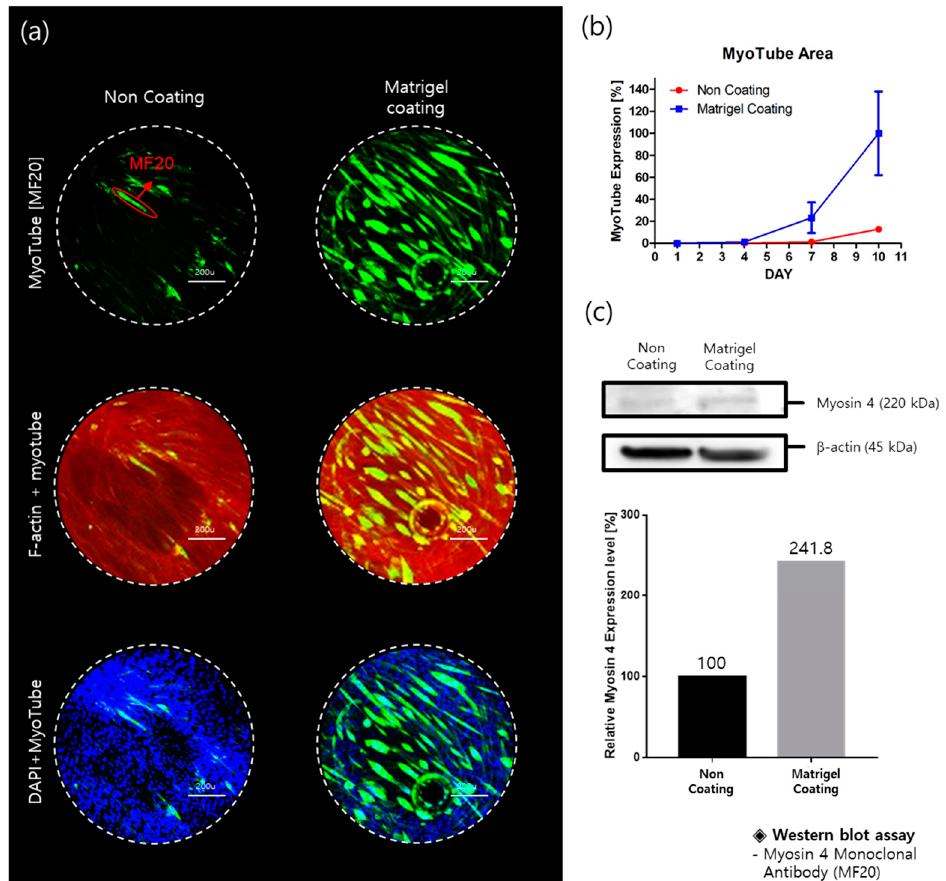
Figure 3. Relative expression of myotube (MF20) as assessed using a pillar strip. ( a ) A comparison of C2C12 cells cultured on uncoated and Matrigel-coated wells. ( b ) Myotube (MF20) expression extracted from the green fluorescence area of the non-Coating and Matrigel-Coating conditions. ( c ) Myotube (MF20) Western blot assay of the non-coating and Matrigel-coating conditions.